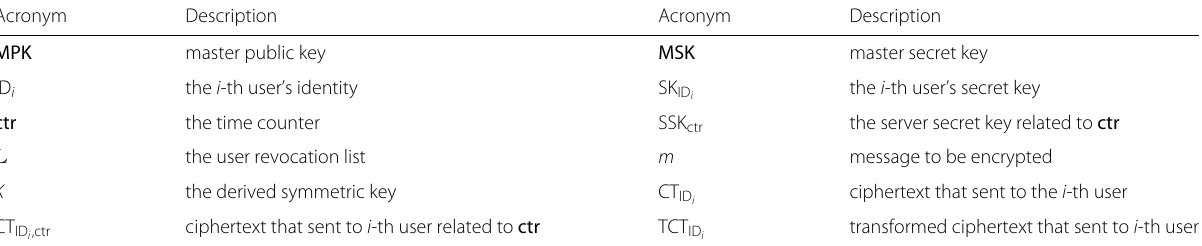
Table 1 Acronyms used in this